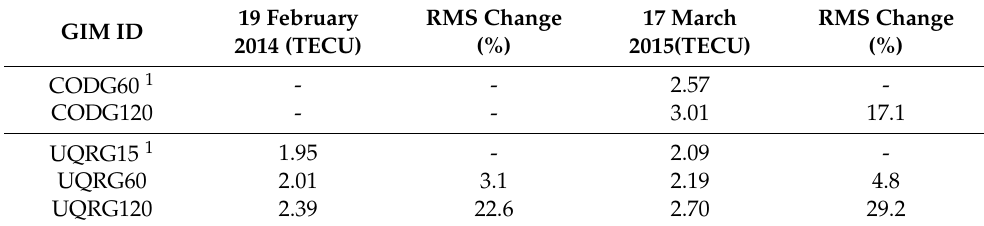
Table 6. Daily RMS from GNSS-STEC comparisons during analyzed storms. GIM